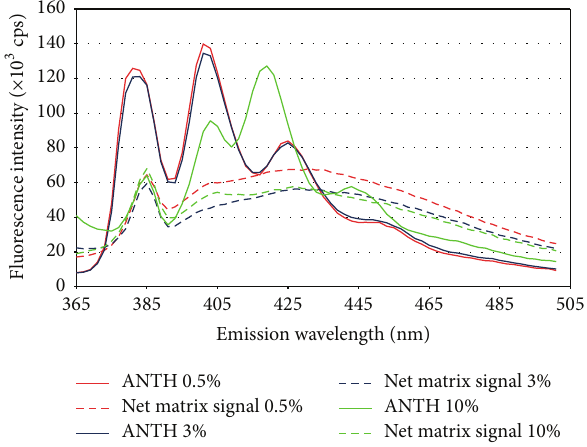
Figure 2: Emission spectra with 𝜆 excitation = 340 nm of the 22.5 ng/mL anthracene solutions and the net matrix signal fluores- cence